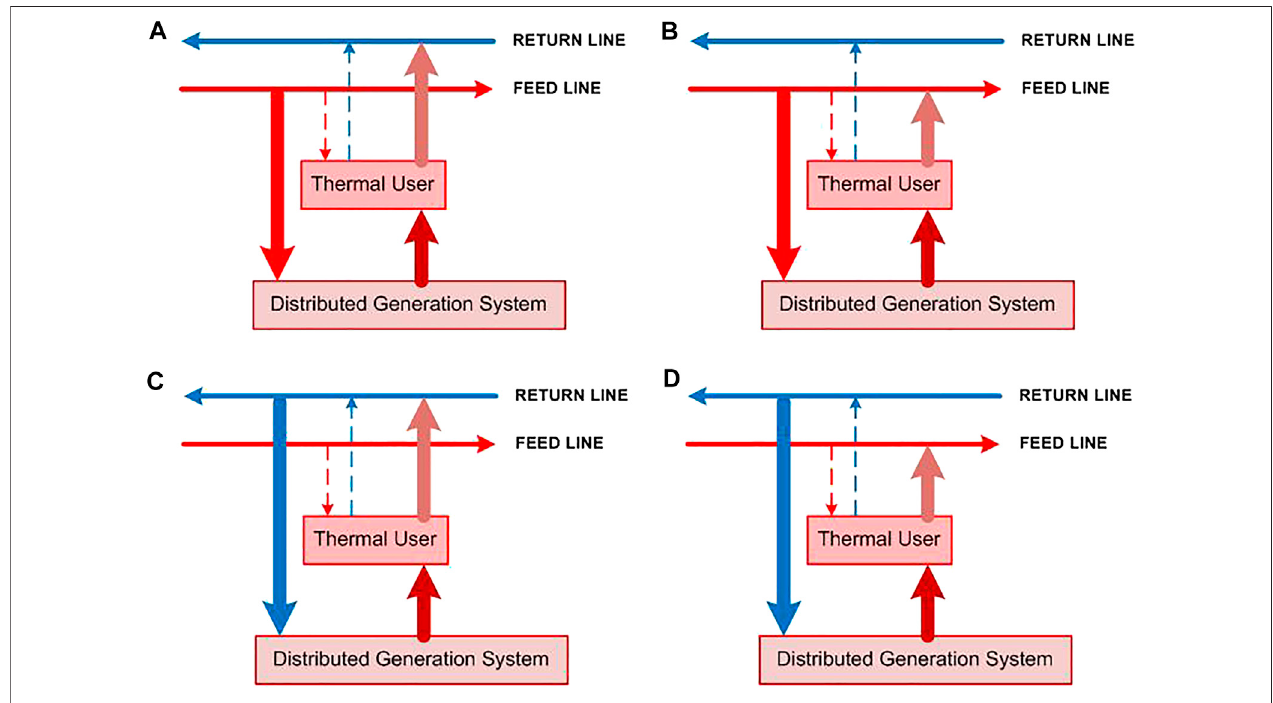
FIGURE 1 | Schematic representation of (A) Scheme 1: feed to return, (B) Scheme 2: feed to feed, (C) Scheme 3: return to return, (D) Scheme 4: return to feed.